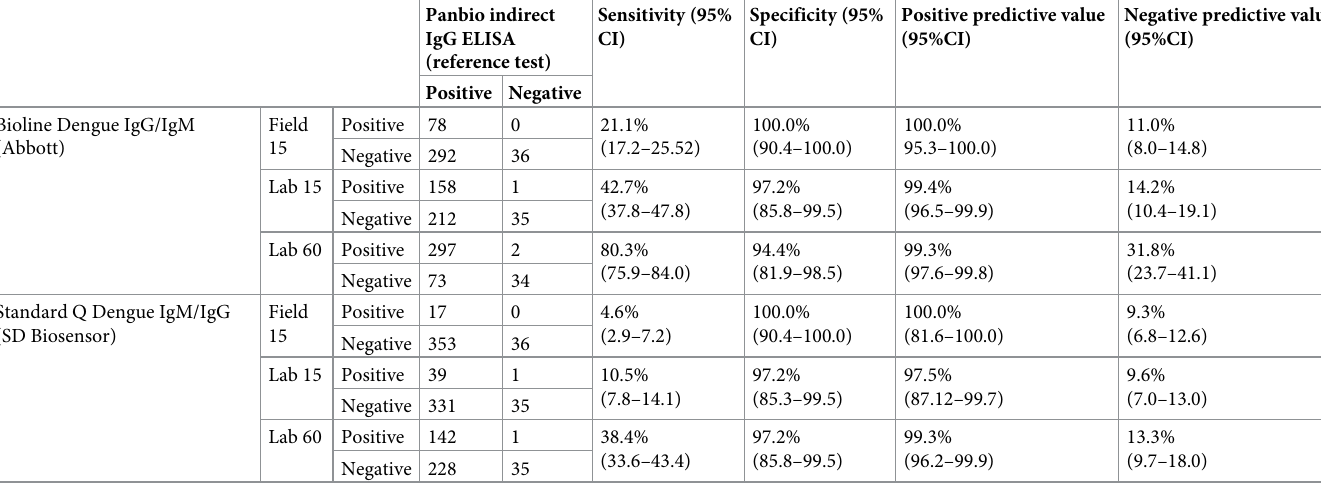
Table 2. Performance of rapid diagnostic tests (RDTs) when operated under different test conditions.